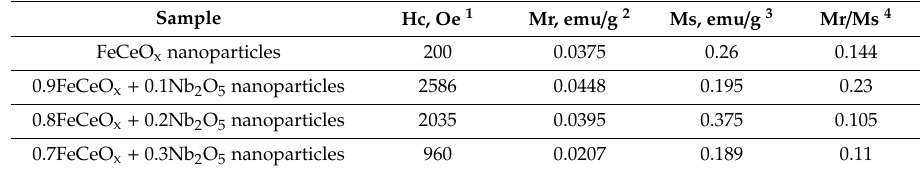
Table 2. Magnetic characteristics data.